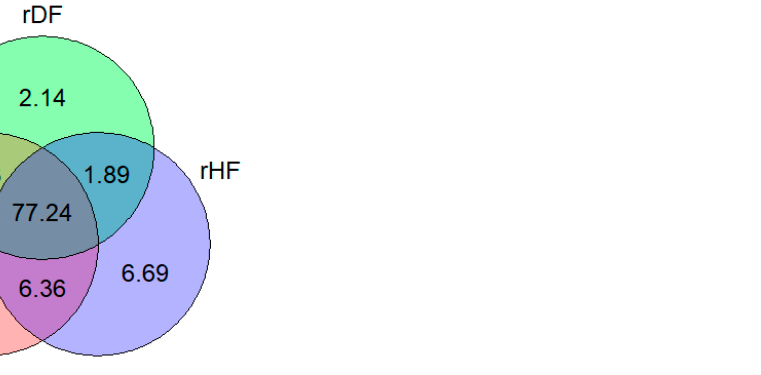
Figure 1. Venn diagram showing percentage of shared and group-specific variants in each group. The genetic structure of the three groups assessed with the first three principal com- ponents of PCA accounted for 13.5% (PC1), 6.4% (PC2), and 5.6% (PC3) of the total varia- tion (Figure 2). The first principal component (PC1) distinguished hDF and rDF from rHF. The hDF group differentiated across the second principal component (PC2), while rDF grouped more together, although overlapping with hDF. One rDF animal was positioned away from the other rDF animals along PC2. The third PC distinguished variation within the rHF, indicating one sire more distantly from the others.